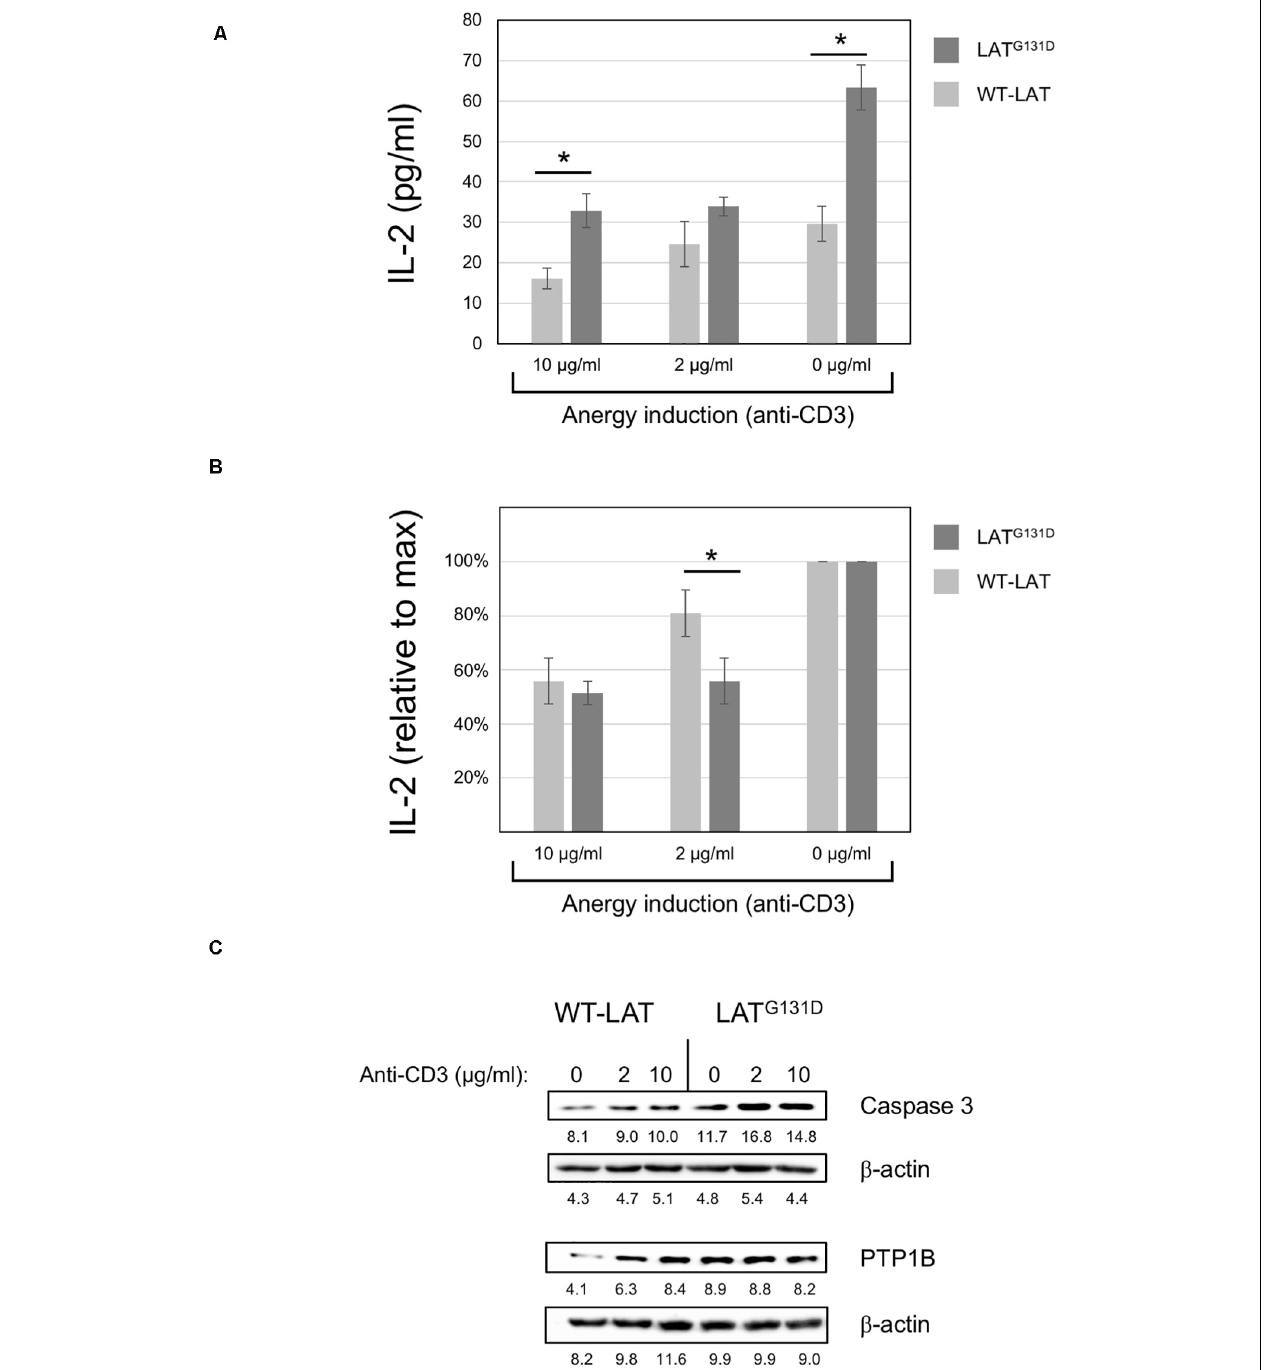
FIGURE 4 | Anergy induction in J.CaM2 cells expressing the LAT G131D mutant. (A) Anergy was induced in J.CaM2 cells expressing human WT-LAT or the LAT G131D mutant by culturing cells overnight on plates with the indicated doses of the immobilized anti-CD3 antibody. Recovered cells were then stimulated with anti-CD3/CD28 microbeads for 48, and the amount of IL-2 in supernatants was measured by ELISA. The values presented are the mean values of four independent experiments. Bars represent the standard error. (B) The relative effect of anti-CD3 treatment on IL-2 production in cells expressing WT-LAT or the LAT G131D mutant. Maximal IL-2 production in cells treated without anti-CD3 mAb (0 µ g/ml) for each type of cell was considered 100%, and the relative production of IL-2 was calculated for each cell type and condition. (C) Caspase 3 and PTP1B levels in cells treated overnight with the indicated doses of immobilized anti-CD3 antibody were analyzed by Western blot (upper panels). Stripped membranes were blotted with anti- β -actin mAb to show equal protein expression (lower panels). The numbers below each panel represent the quantification of corresponding bands. Representative images from one of the three experiments performed with similar